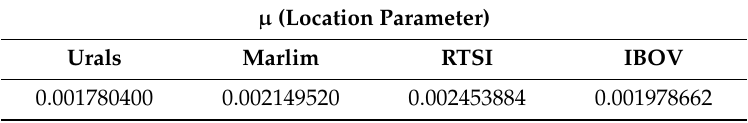
Table A22. MNIG Location parameter µ for Vector 6: Urals, Marlim, RTSI,